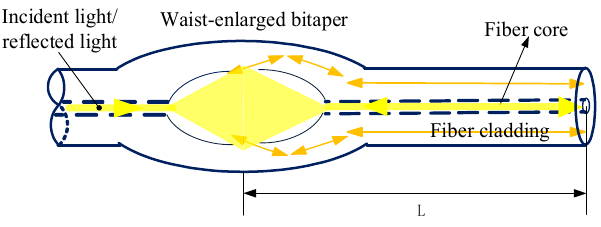
Figure 1. Schematic diagram of Michelson interferometer.